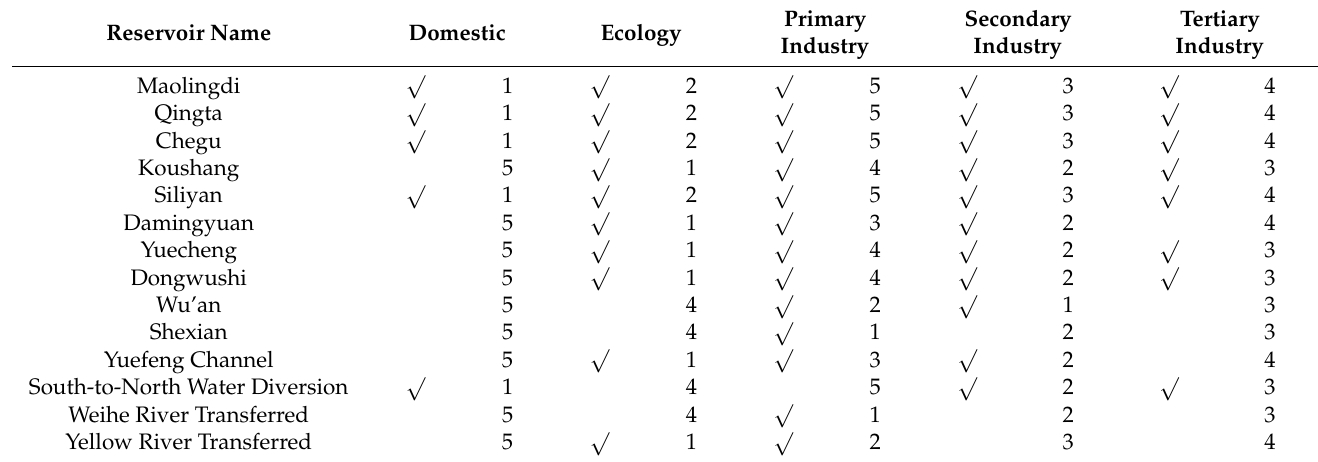
Figure 3. The network diagram of the water supply relationship in Handan. Parameters Setting Table 3. Water supply relationship and water supply level of the reservoir to The allocation ratio coefficient of water sources of the industry is set. According to the requirements of different water users for water supply sources, the water allocation ratio of different water sources to the corresponding industries for each calculation unit in Handan is determined. The industry weight coefficient is set to 1 for domestic and ter- tiary industry, 0.95 for ecology, 0.8 for primary industry, and 0.9 for second industry.